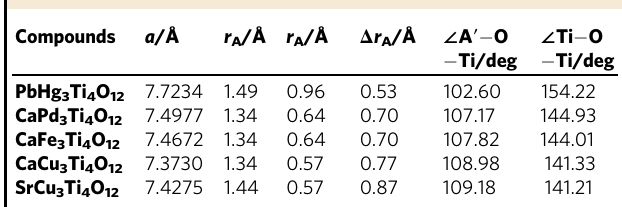
Table 2 Lattice constant a , ionic radius of A-site r A , ionic radius of A ′ -site r A ′ , difference between ionic radii of A- and A ′ -site ions Δ r A , metal − oxygen bond angles ∠ A ′ − O − Ti and ∠ Ti − O − Ti for some AA ′ 3 Ti 4 O 12 type perovskite compounds 33 .